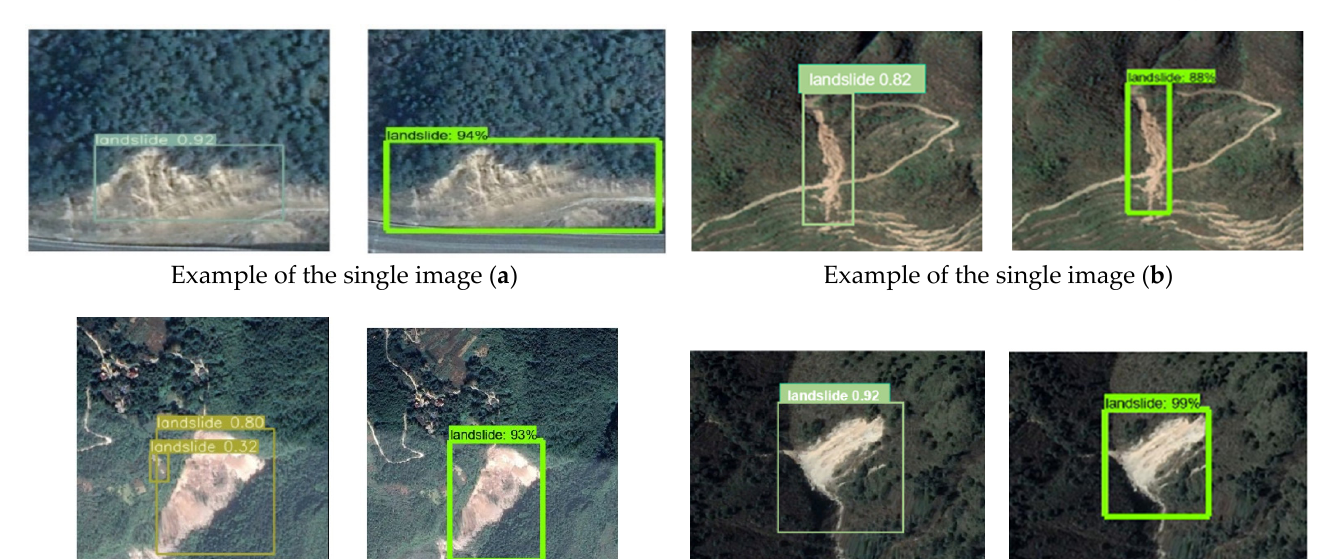
Figure 9. The loss curves of the SSD model ( left ) and the transfer learning model ( right ).